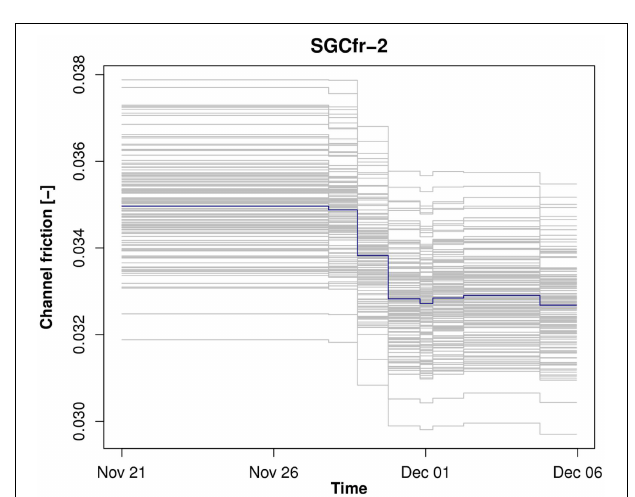
FIGURE 6 | Evolution of the estimate of the global Manning’s friction coefficient during the sequential assimilation steps for the three major rivers (Severn, Avon, and Teme) for a filter estimating friction but not bathymetry. Gray lines show the ensemble, and blue line is the mean (after Garcia-Pintado et al.,